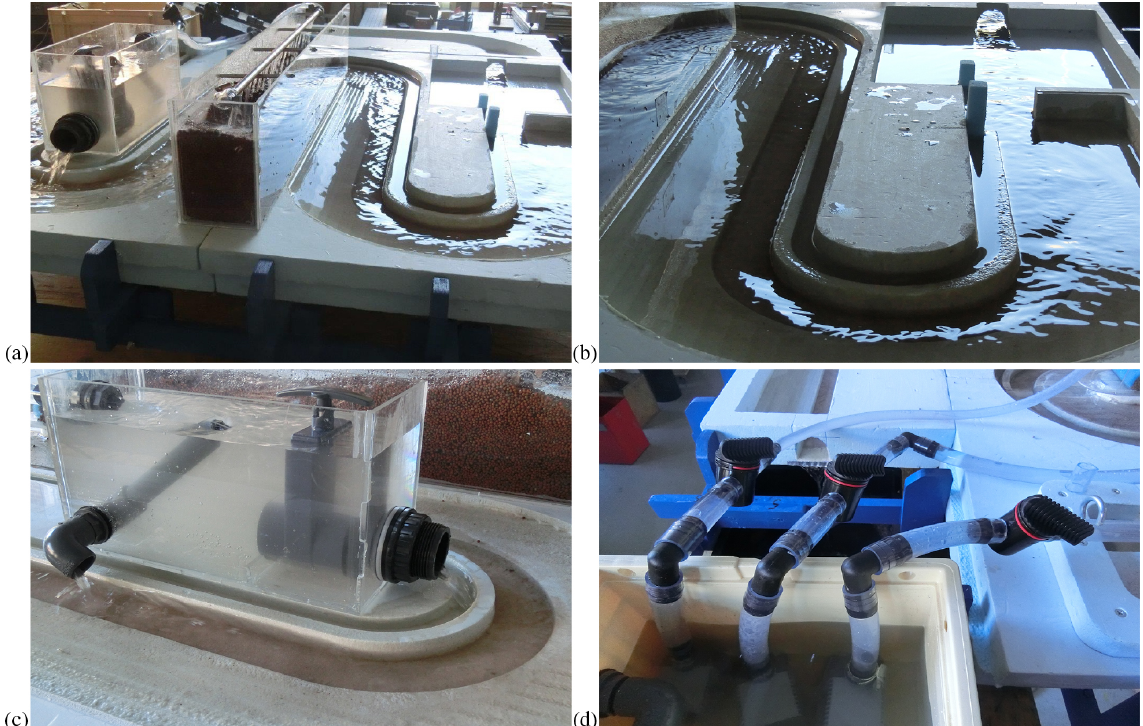
Figure 7. Action shots of Wetropolis: (a) overview of overflowing reservoir on the left, the lave-grit-filled moor under heavy rainfall in the middle, and a flooded city in the background on the right during tests with massive flooding and 100% rainfall over several days; (b) zoom-in of the final river bend and its one-sided flood plain and the canal before the city as well as a flooded city plain in the background on the right during massive flooding; (c) zoom-in of the reservoir with water streaming through the manually adjustable outflow pipe into the river and the separate valve-adjustable underflow into the canal on the right; and (d) zoom-in of the holding reservoir with the three aquarium pumps and tubing leading to the constant upstream inflow at the start of the river at s = 0 on the right and two other tubes leading to the reservoir and